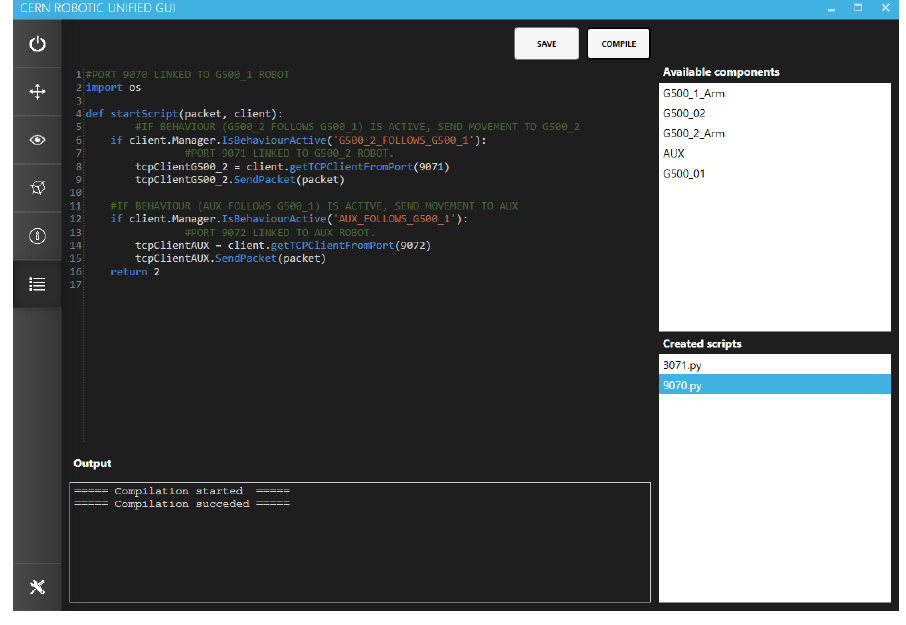
Figure 13. HRI script